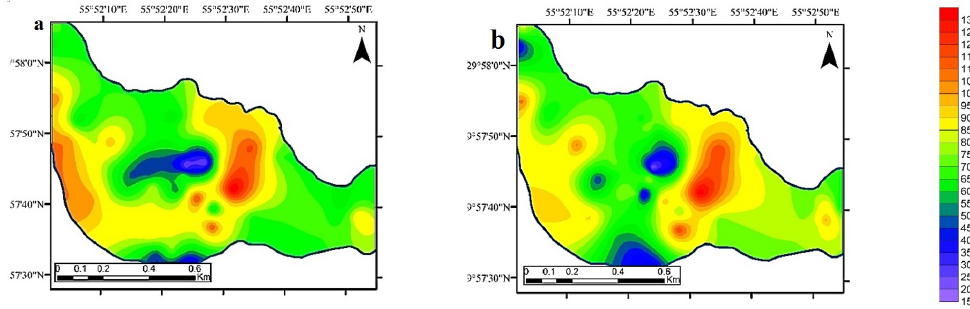
Figure 8. Spatial distribution maps of Cr measured ( a ) and predicted by an SD-ANN method ( b